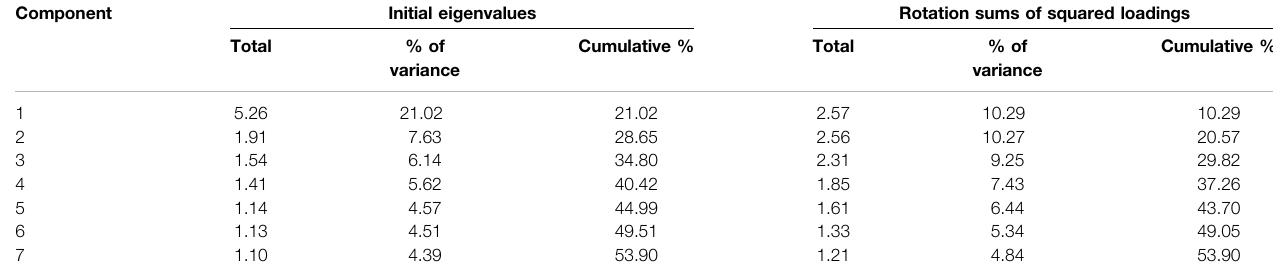
TABLE 2 | Global information from the Kaiser method. Component